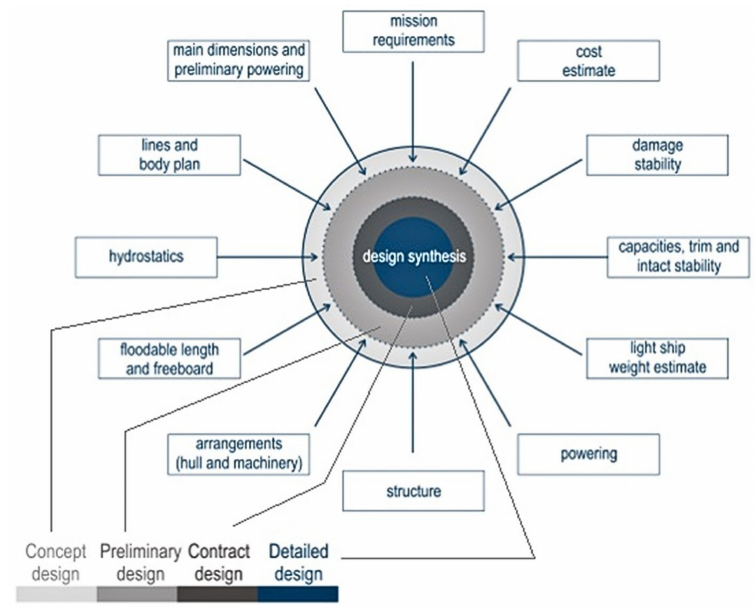
Figure 2. New integrated ship design process